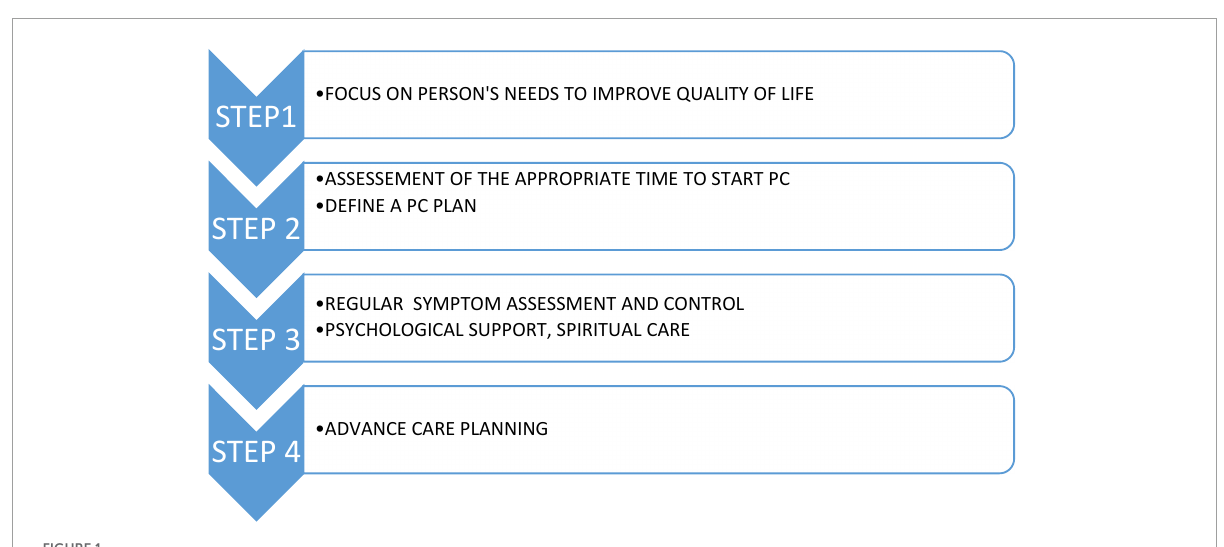
FIGURE1 Steps in PC in people living with CHF and COPD; based on (1–3). CHF, chronic heart failure; COPD, chronic obstructive pulmonary